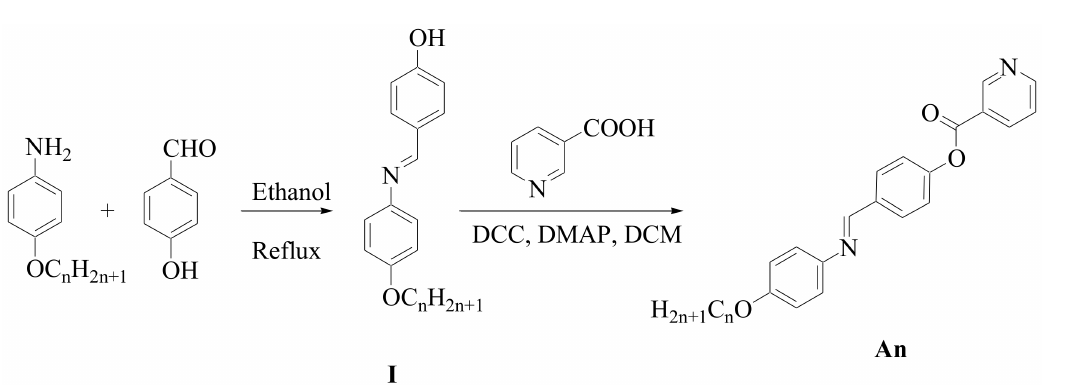
Figure 7. Binary phase diagram of ( a ) A6 / A8 and ( b ) A6 / A16 . “ nematic–isotropic liquid